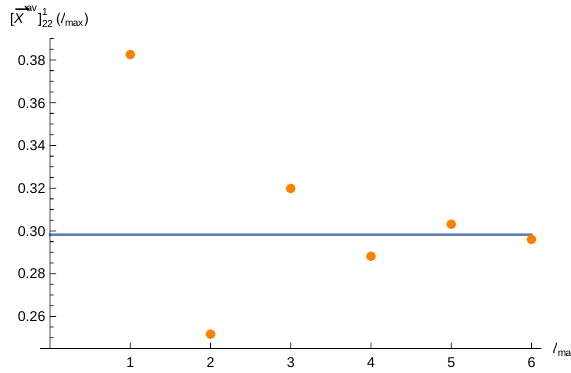
(cid:2) ~X av (cid:3) 1 ( ‘ max ) in the range [0 : 245 ; 0 : 390] plotted against ‘ max . Blue 22